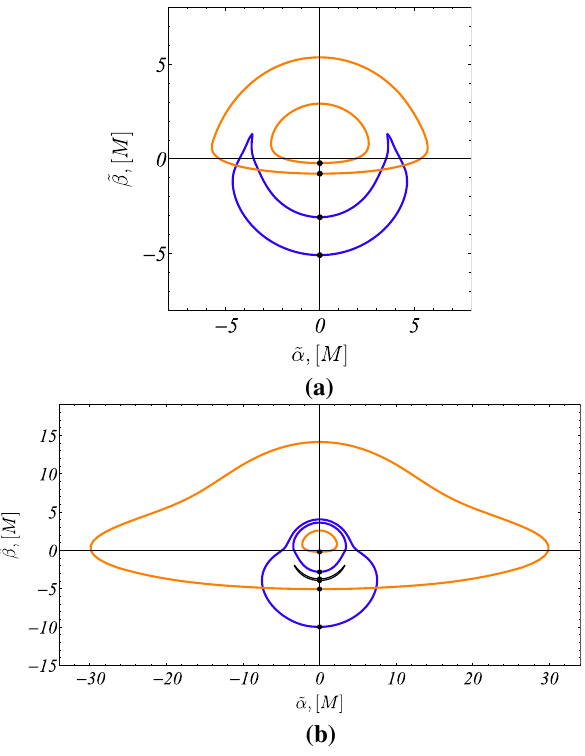
Fig. 13 Images of point light sources (black dots) located at the azimuthal angle φ = 0 and radial coordinates r = 5 . 896 M ( a ) and r = 30 M ( b ) in the spacetime of the strongly naked singularity with γ = 0 . 48. For small radial distances the point source possesses four distinct images, while for larger radii two more images of order k = 2 appear